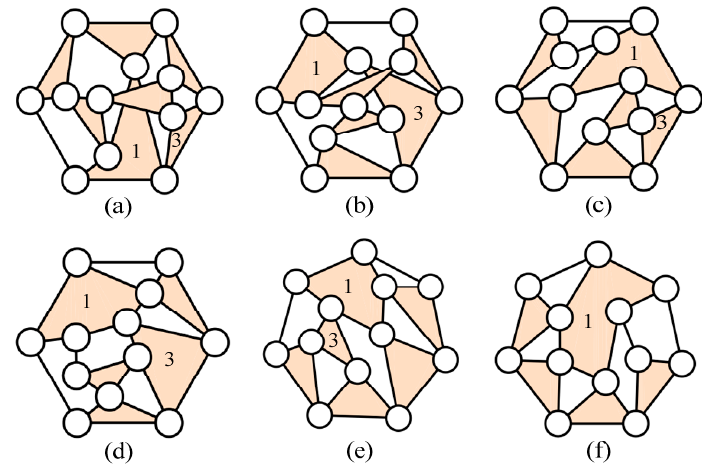
Figure 3. Specialized chains with identified ground link and the carrier of double PGT.